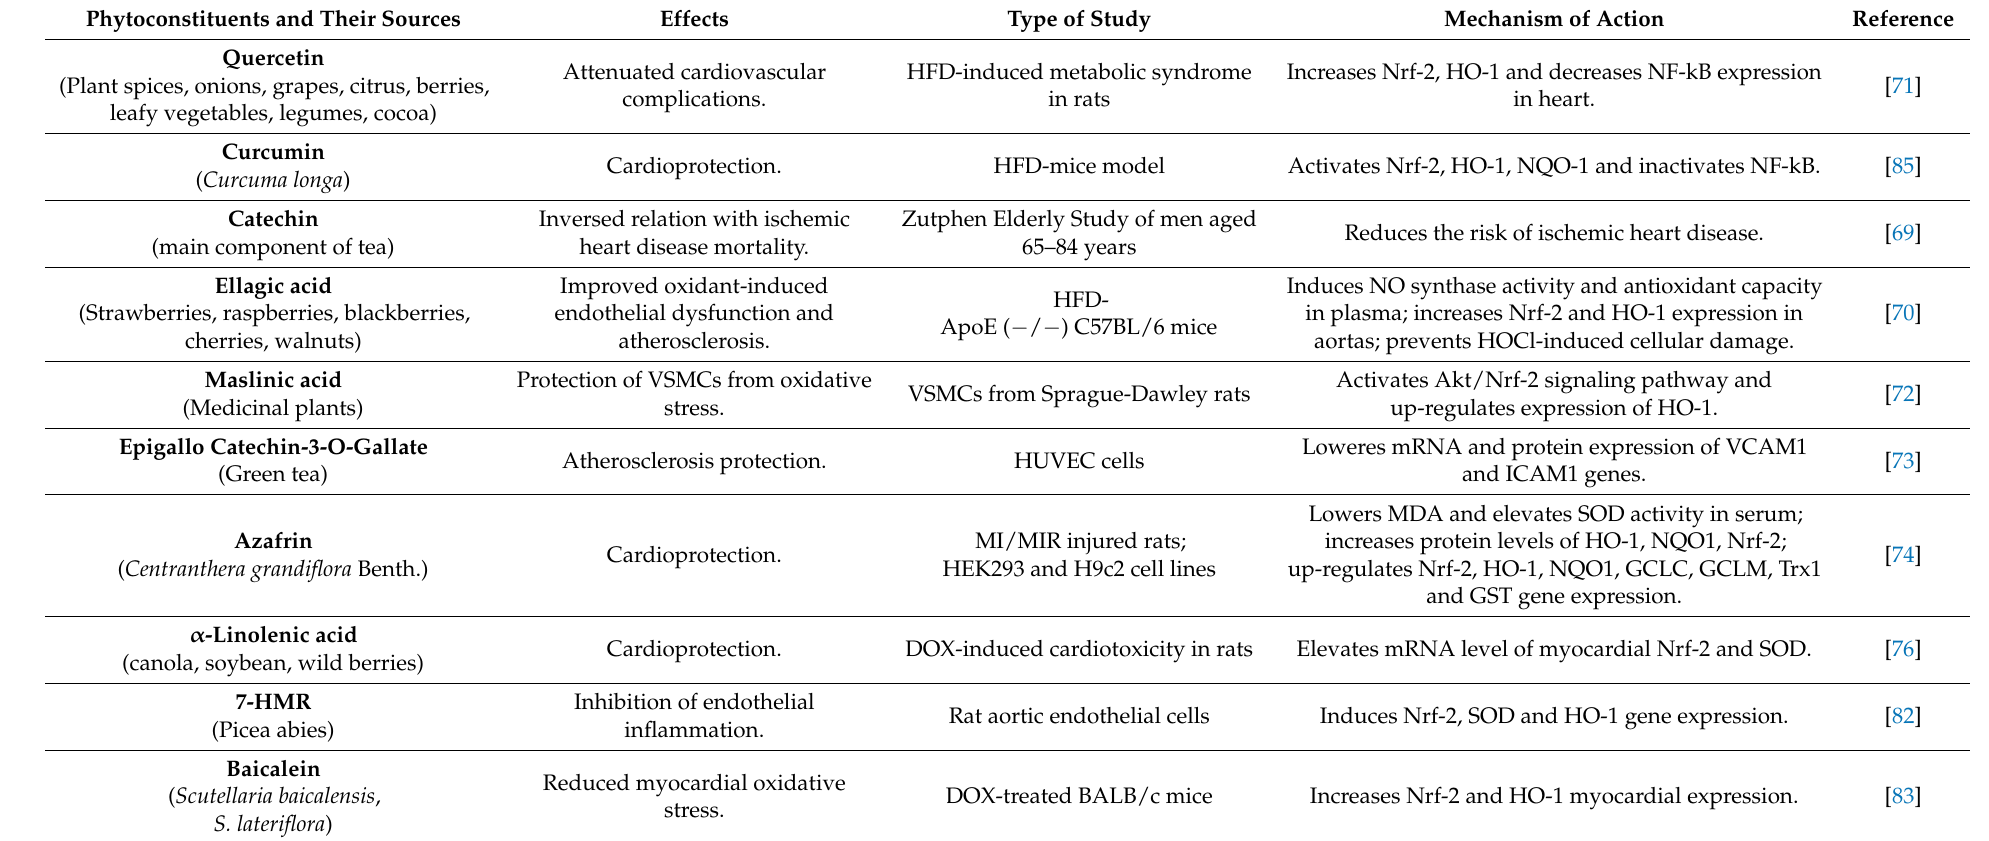
Table 6. Phytoconstituents attenuate diabetic cardiovascular